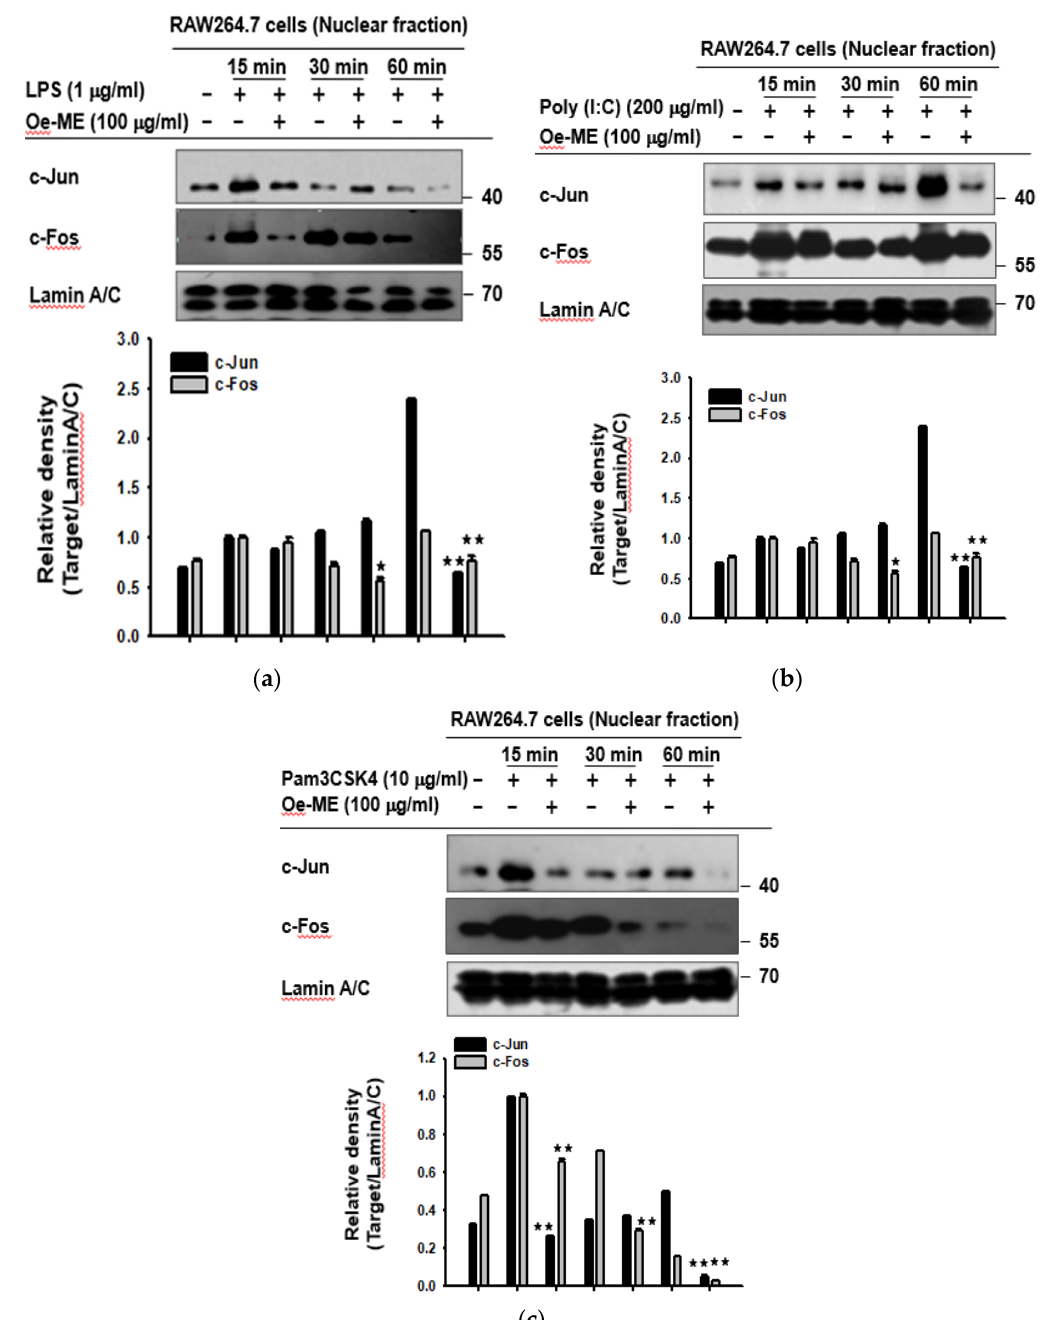
Figure 2. The role of Oe-ME in the transcriptional activation of AP-1. ( a ) After being pre-incubated with Oe-ME for 30 min, RAW264.7 cells were stimulated by LPS for intended periods of time (15, 30, and 60 min). Levels of c-Fos, c-Jun, and Lamin A/C in nuclear fractions were determined by immunoblotting analysis. ( b , c ) Similarly, TLR agonists of TLR2 and -3 were used to induce RAW264.7 cells. c-Fos, c-Jun, and Lamin A/C from nuclear fractions were subjected to immunoblotting analysis. Band intensity was measured and quantified using ImageJ. * p < 0.05 and ** p < 0.01 compared with LPS alone treated with the corresponding concentration of the vehicle (DMSO).